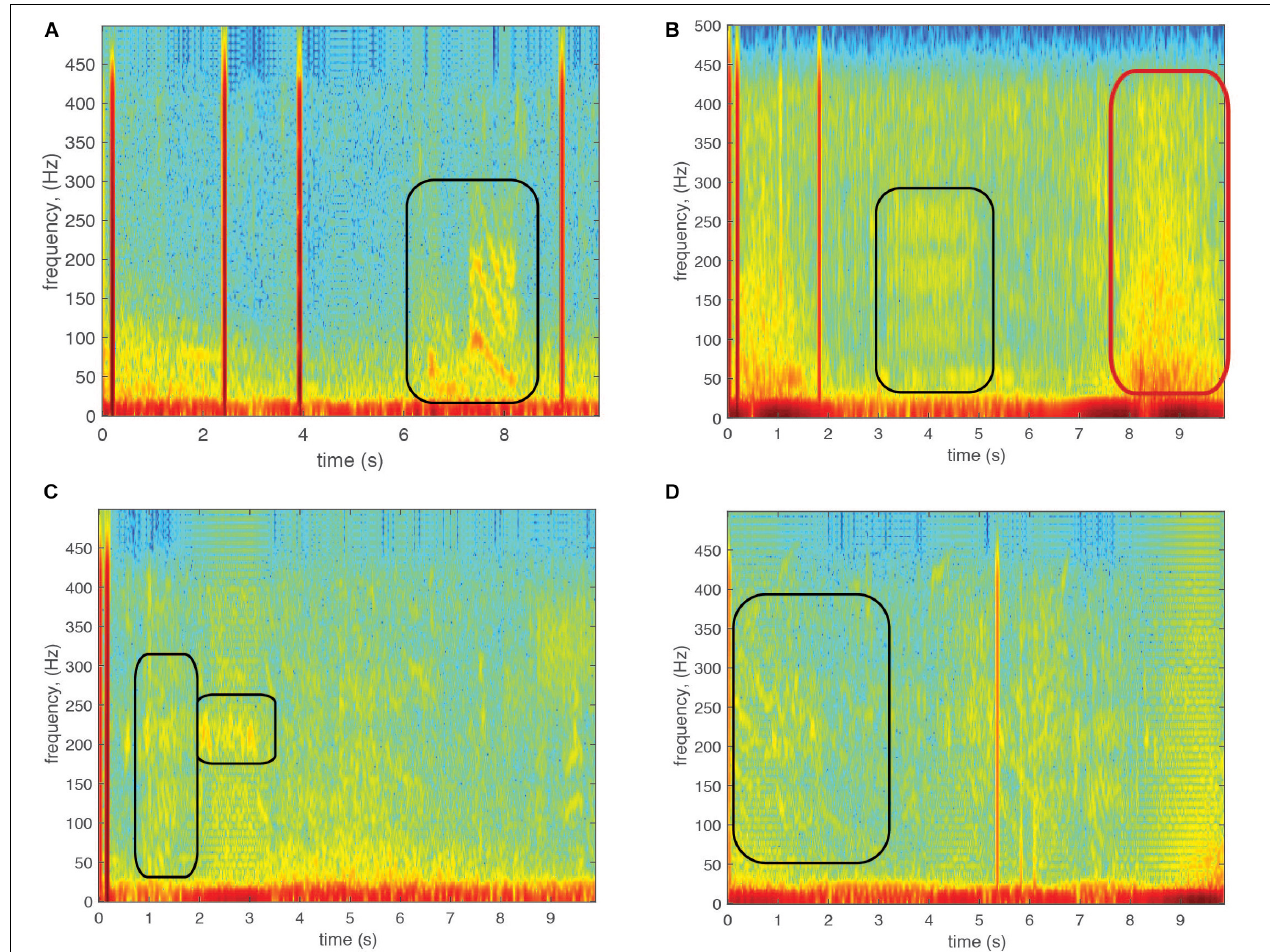
FIGURE 3 | Fish call spectrograms recorded with the Wave Glider PAM in the Virgin Islands. (A) Nassau grouper. (B) Yellowfin grouper. (C) Red hind grouper tonal and chorus call. (D) Red hind grouper tonal call. The black rectangles identify the calls. The red rectangle shows the wave noise.